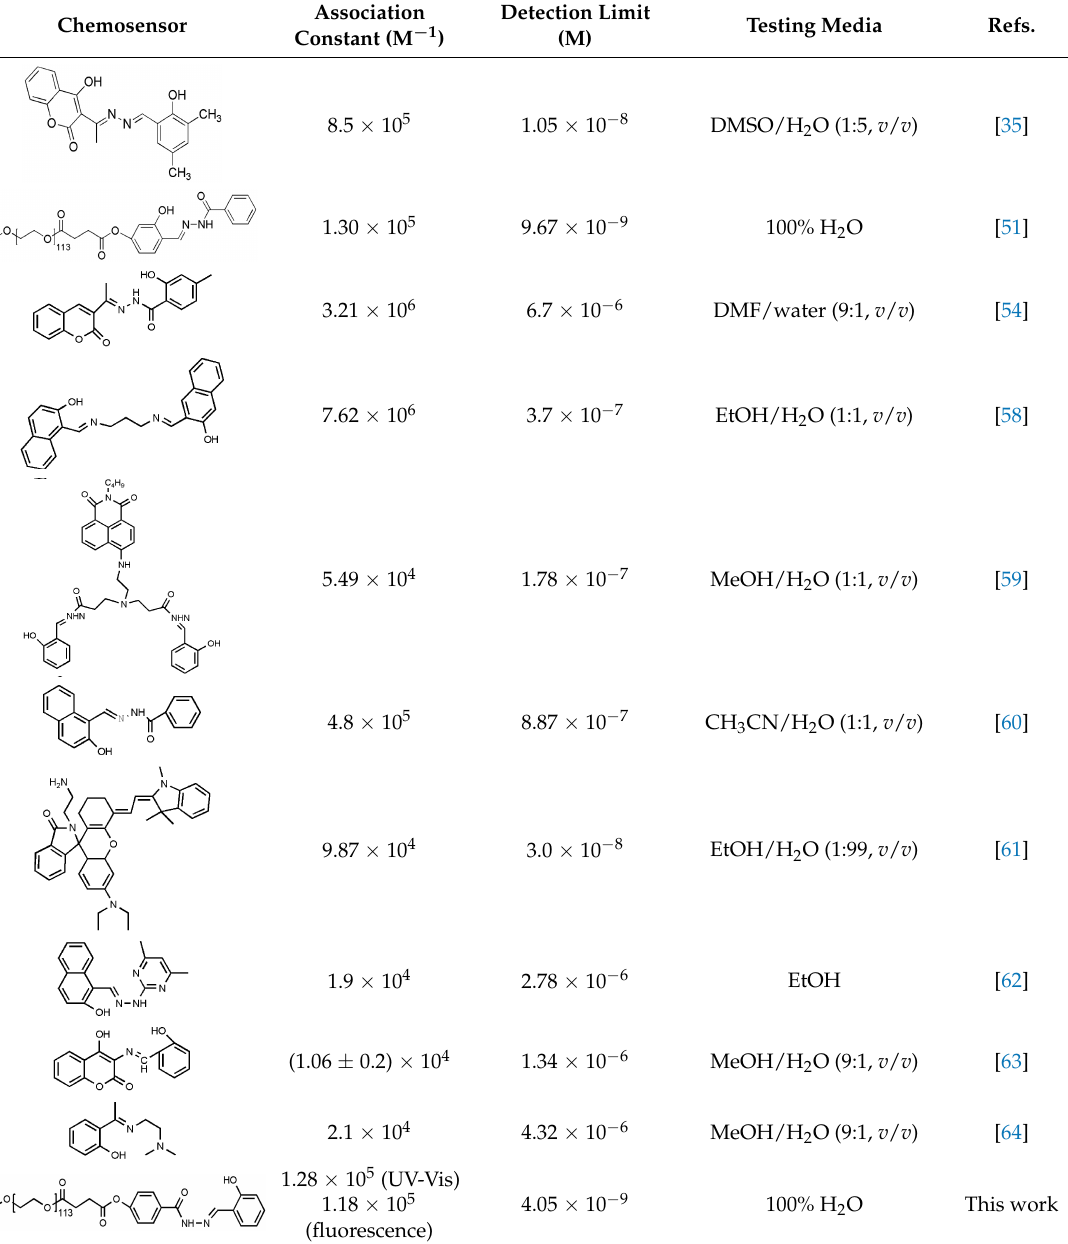
Table 1. Comparison of PEGBAB with some reported chemosensors for the detection of Al 3+ . Chemosensor